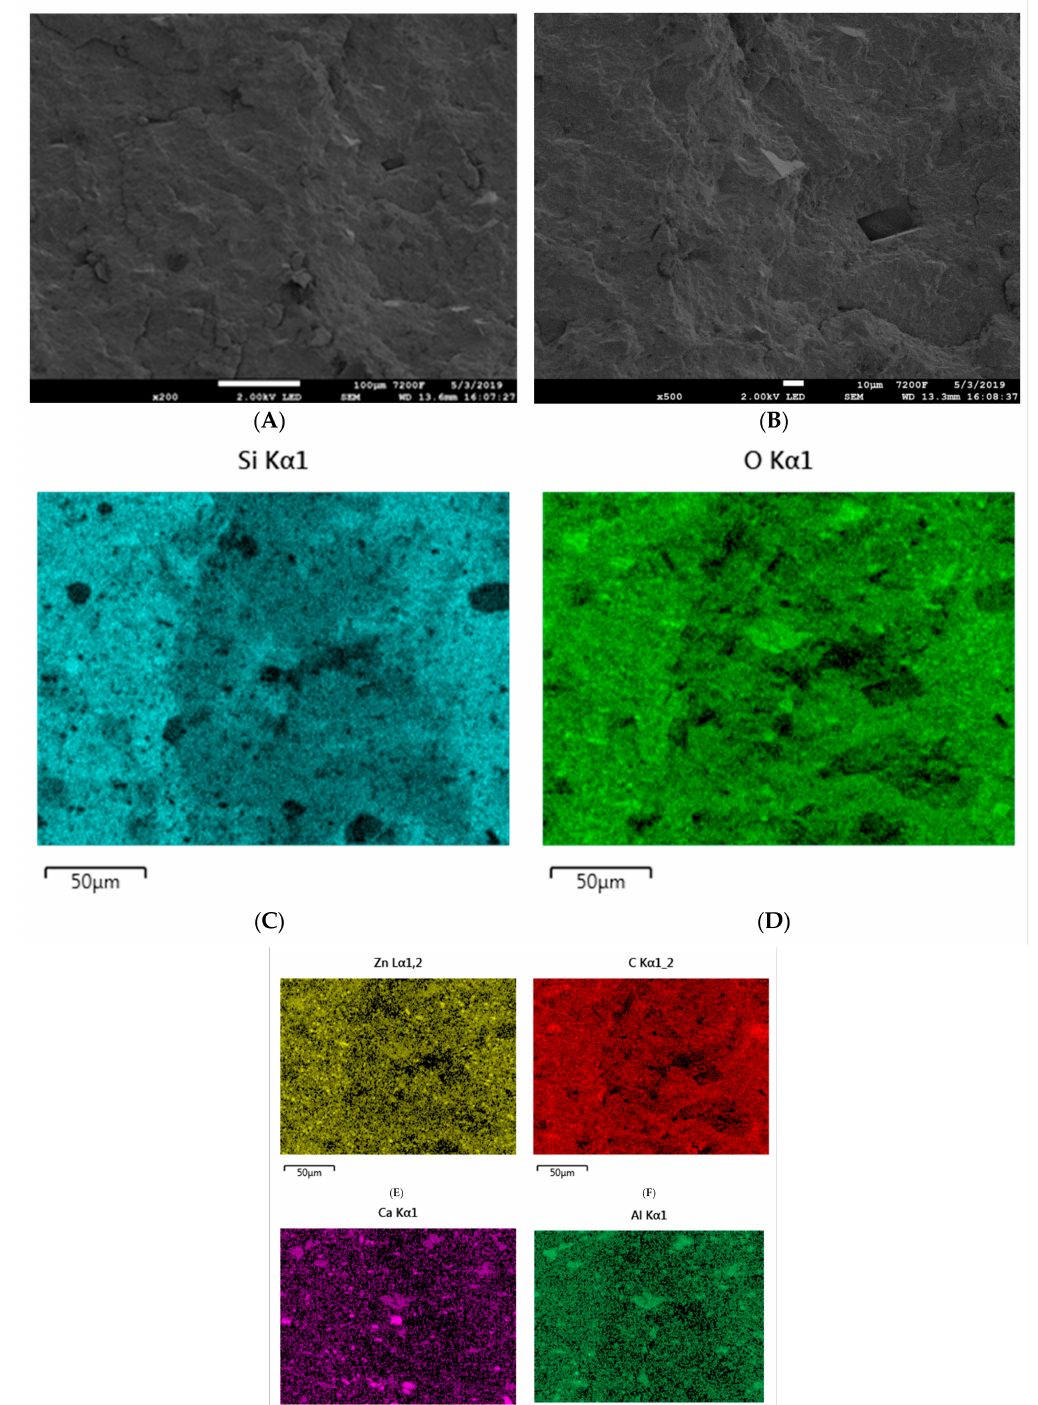
Figure 14. SEM images of the SR-5 composite at magnifications of ( A ) × 200 and ( B ) × 500. EDS mapping of SR-5 ( C ) silicon distribution, ( D ) oxygen distribution, € zinc distribution, ( F ) carbon distribution, ( G ) calcium distribution, and ( H ) aluminum